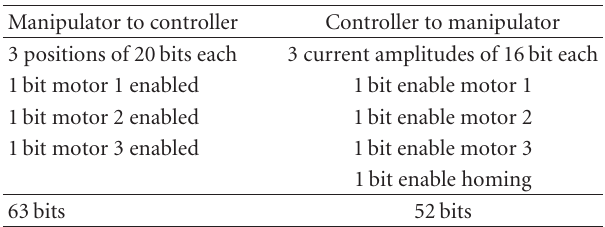
Table 4: Data allocation within the data packets. Manipulator to controller Controller to